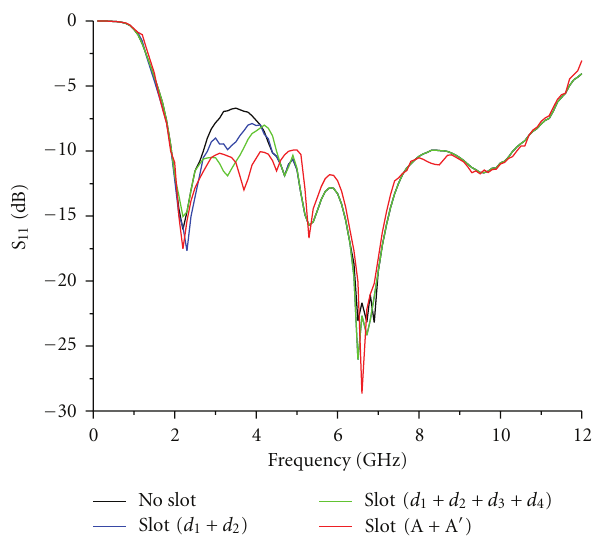
Figure 4: Simulated results of the proposed antenna with and without slots.